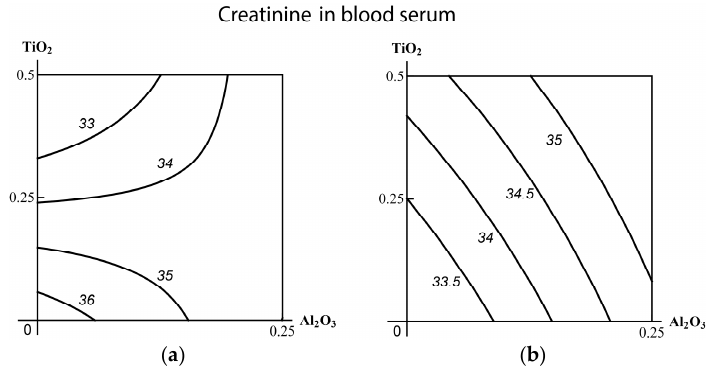
Figure 4. An example of three-factor toxicity falling into class “A”: ( a ) a subadditive or opposite action (for different levels of effect and doses) of the combination (Al 2 O 3 -NP + TiO 2 -NP) in the absence of a third factor on the creatinine content of blood serum transforms (for all effect levels and doses) into ( b ) an additive one in the presence of simultaneously influencing SiO 2 -NPs. Me-NP doses are plotted on the axes in mg per rat. The numbers at the lines correspond to the magnitude of the effect ( µ mol/L).